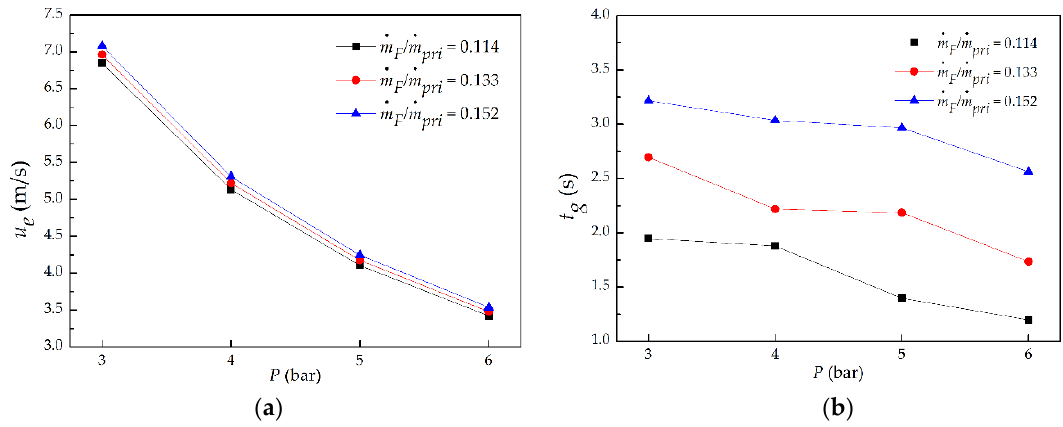
Figure 10. ( a ) Nozzle exit velocity; ( b ) global flame residence time.